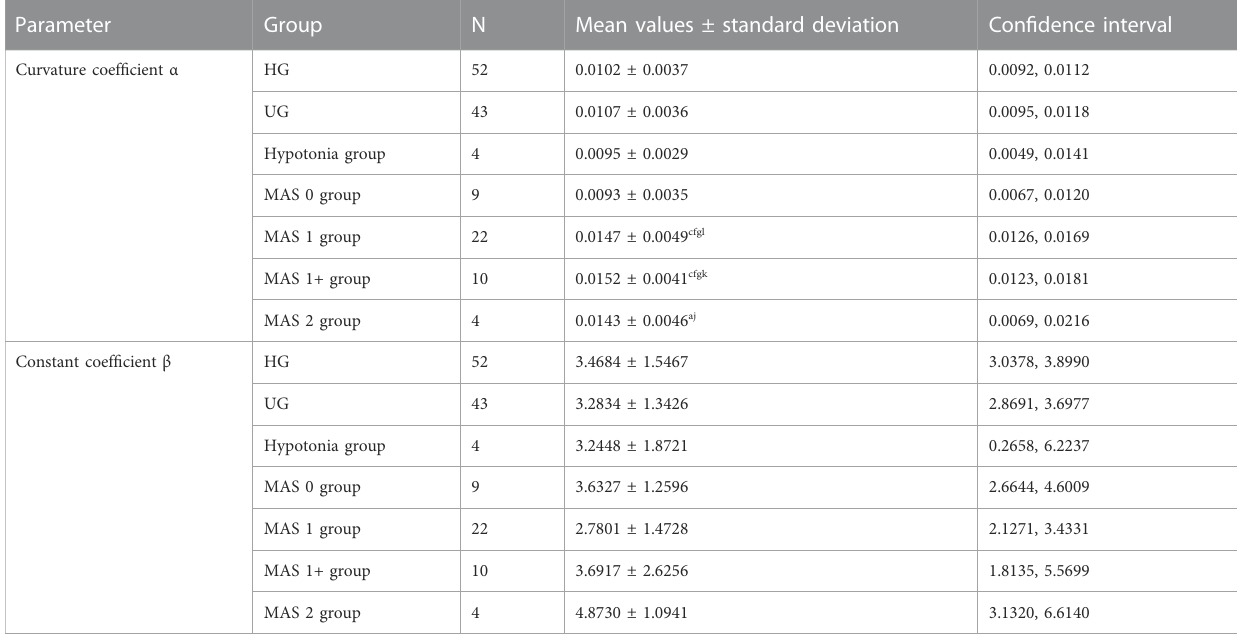
TABLE 4 Curvature coef fi cient α and constant coef fi cient β of each